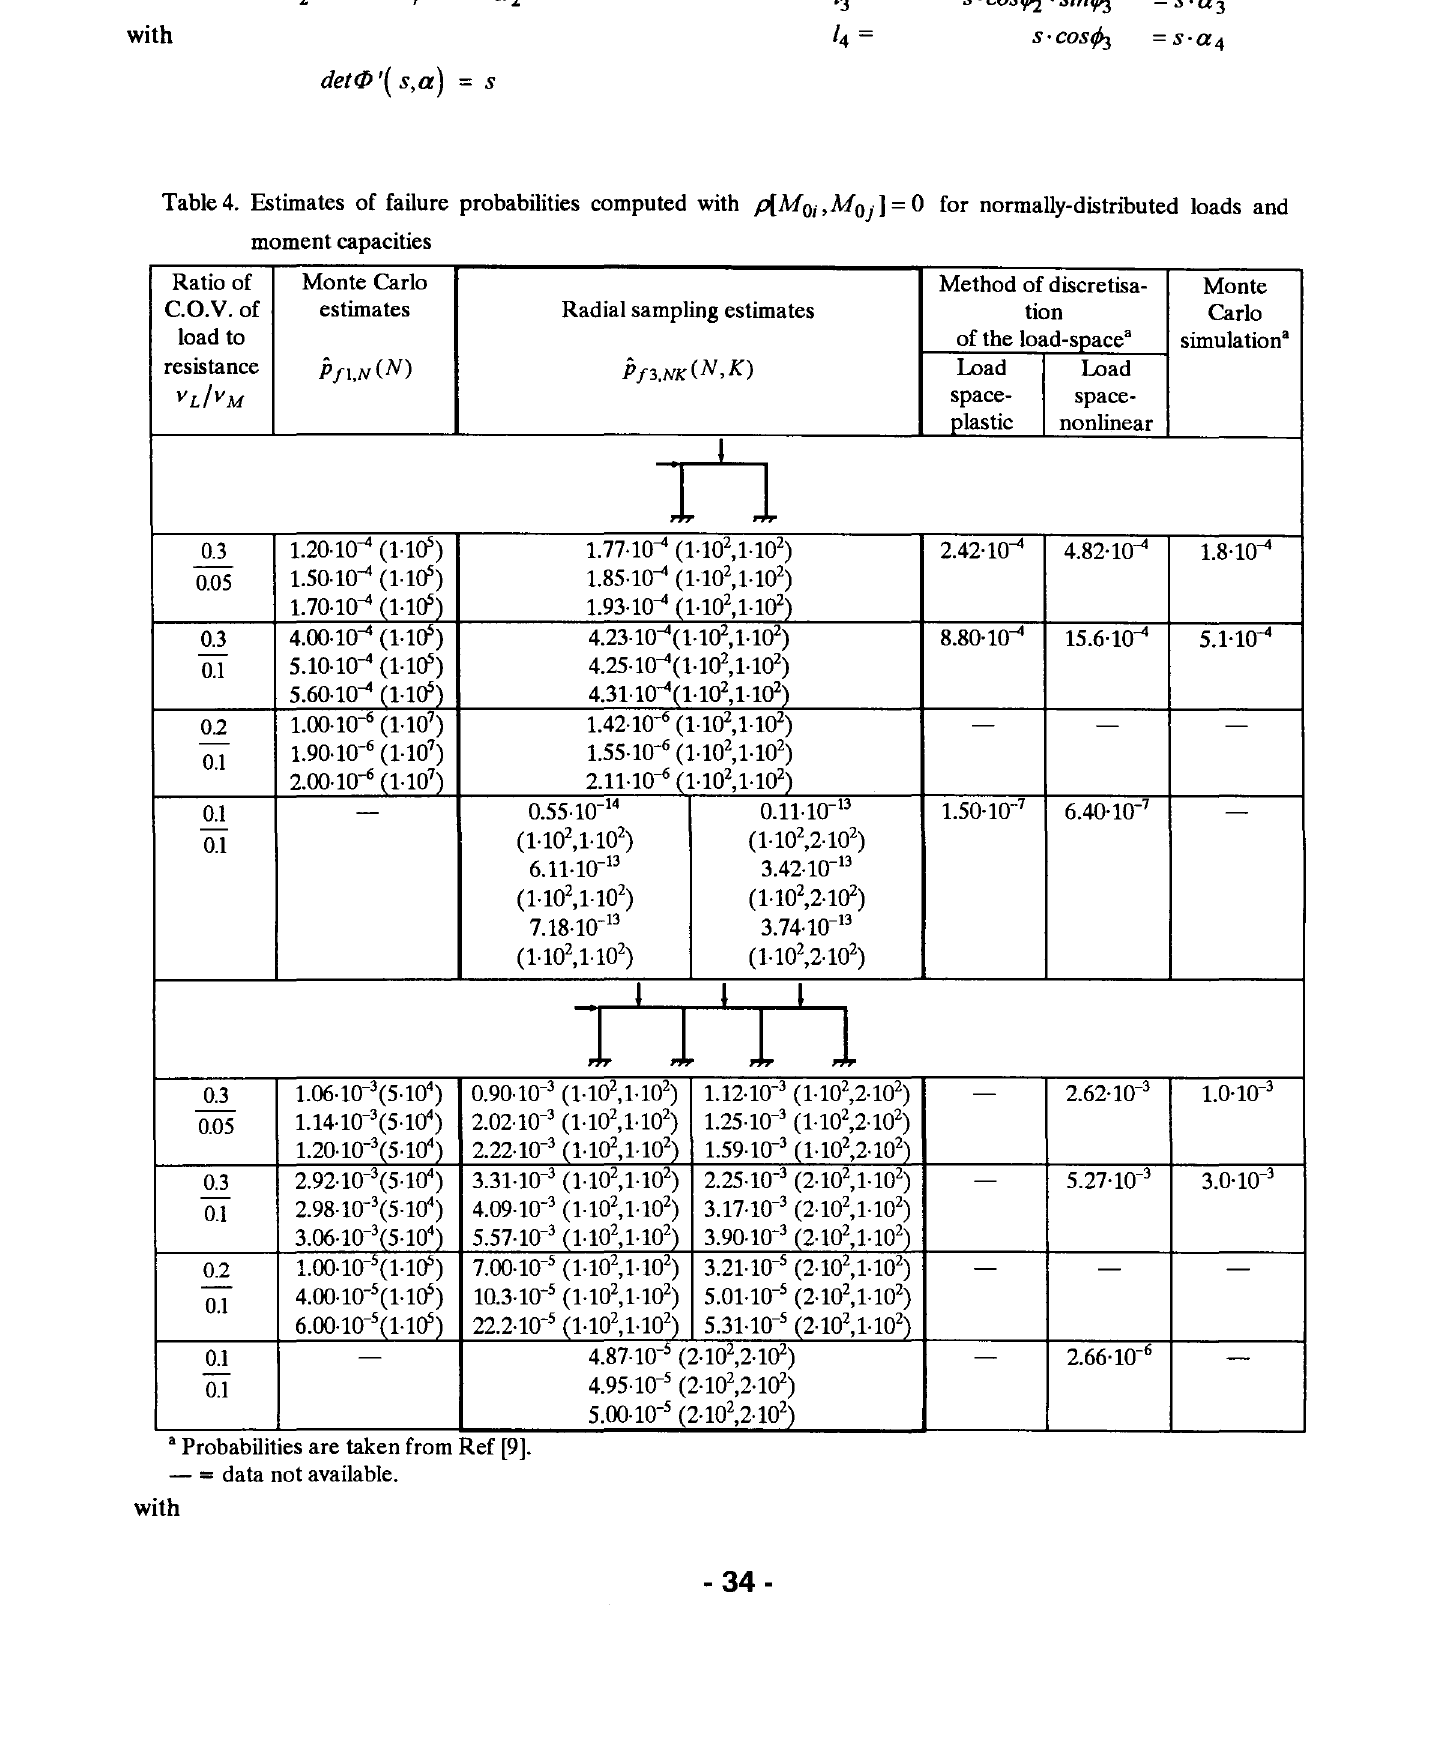
0 for normally-distributed loads 01 ] =